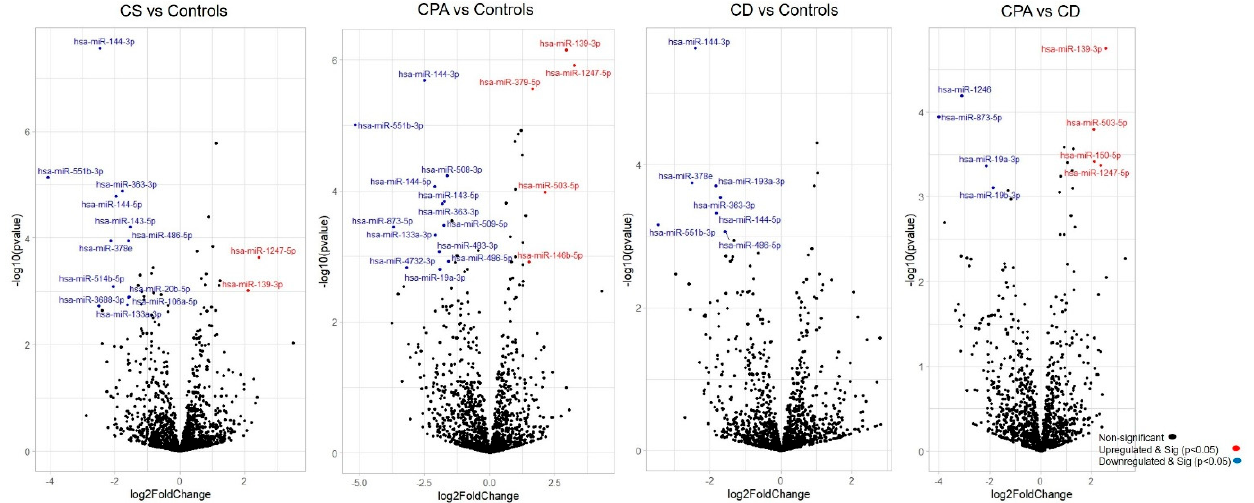
Figure 1. Differentially expressed miRNAs from sequencing. Volcano plot showing the relationship between fold change (log2 fold change) and statistical significance ( − log10 p value). The red points in the plot represent significantly upregulated miRNAs, while blue points represent significantly downregulated miRNAs. CPA, cortisol producing adenoma; CD, Cushing’s disease; Cushing’s syndrome represents CPA and CD, taken together.